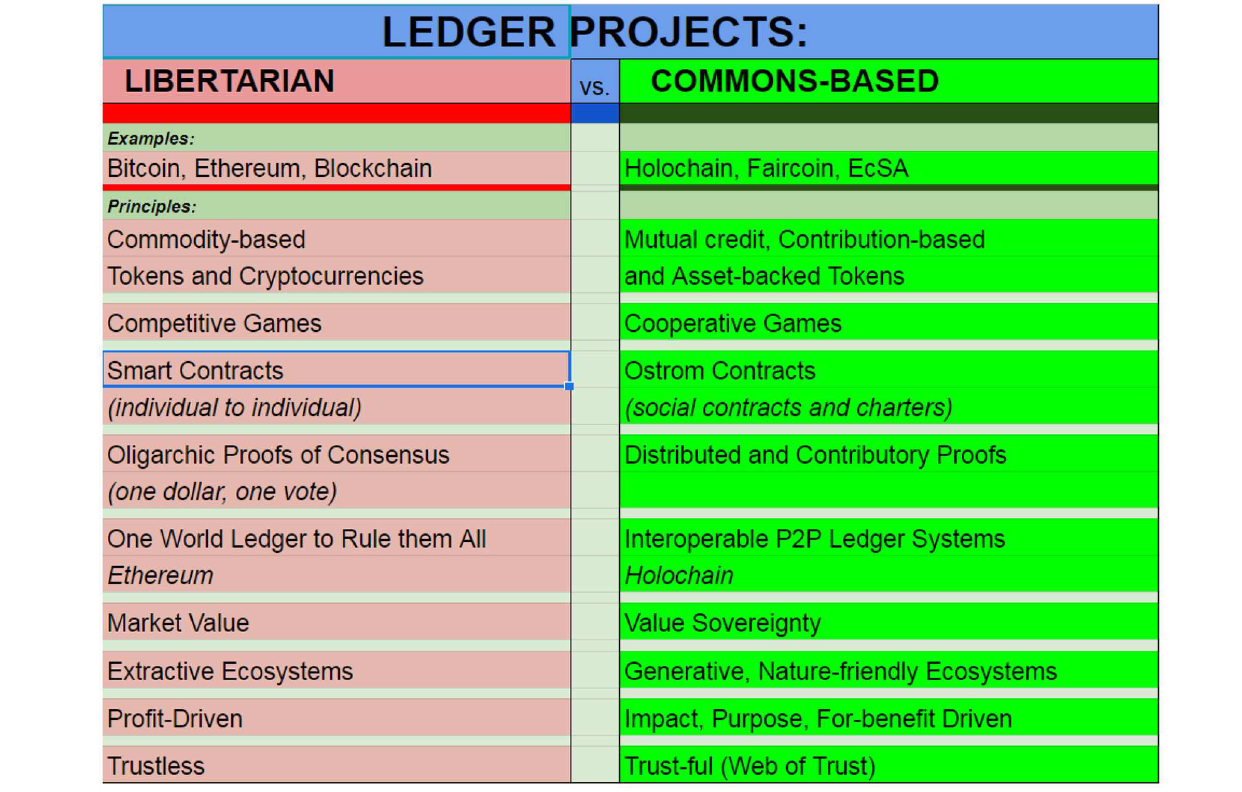
Frontiers in Blockchain |